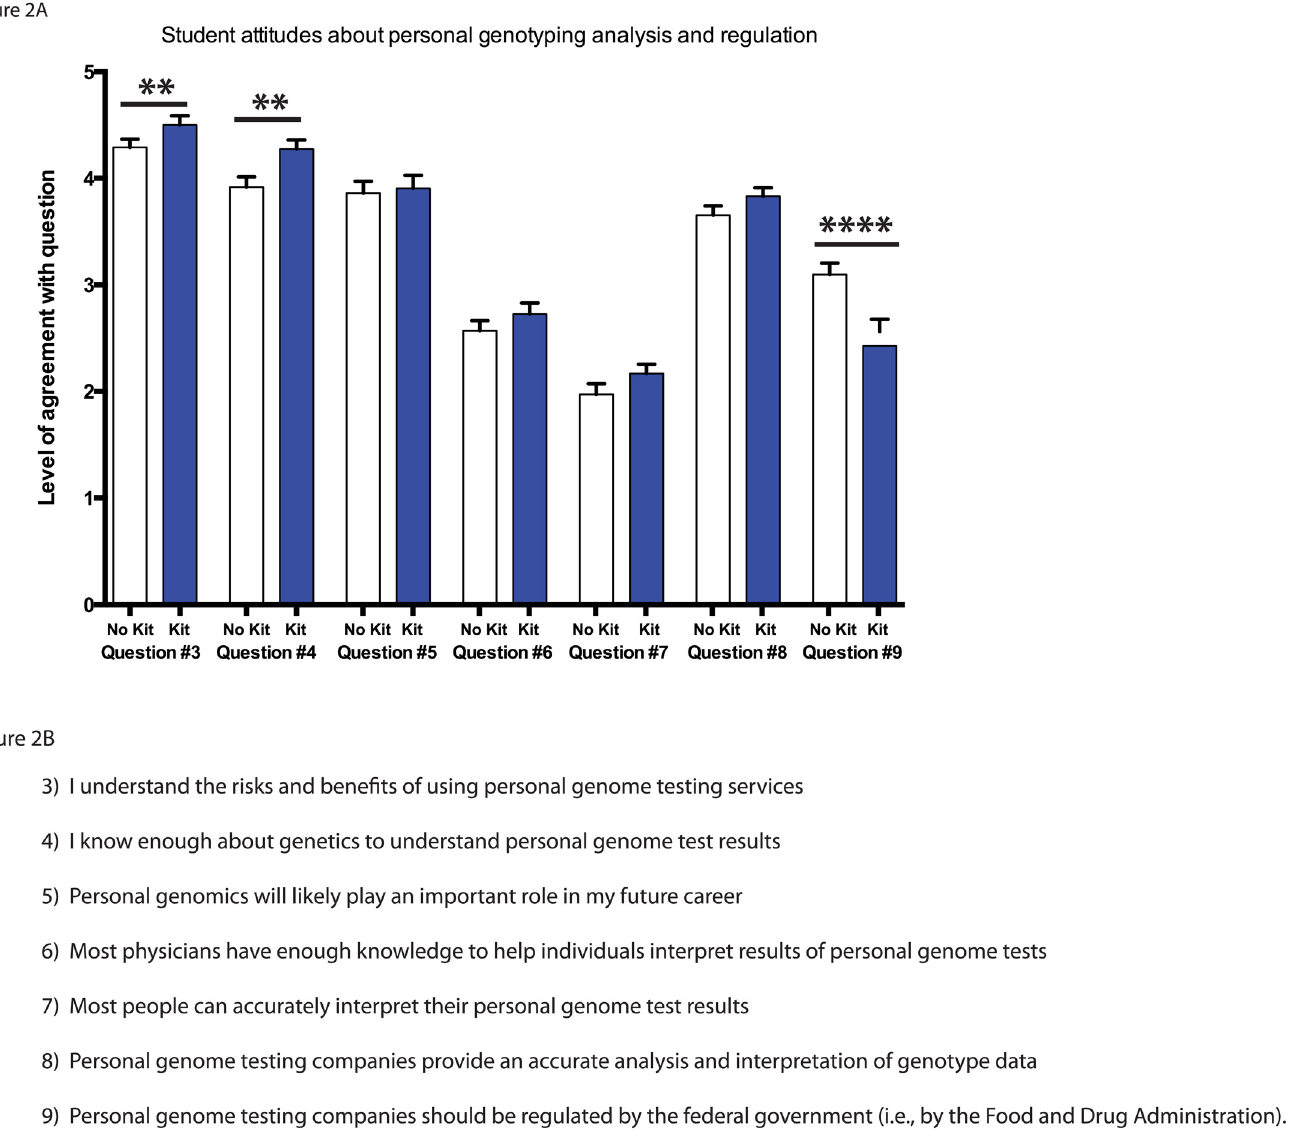
Fig 2. Student attitudes about personal genomics analysis and regulation. A) Student response to statements in questions 3 – 9 on a 5-point Likert scale. Statistical analysis performed using the Mann-Whitney U-test and all values are mean ± SEM with n = 71 for no kit (white), and n = 84 for kit (blue) ( ** = p < .01; **** = p < .0001). B) Student survey questions 3 –